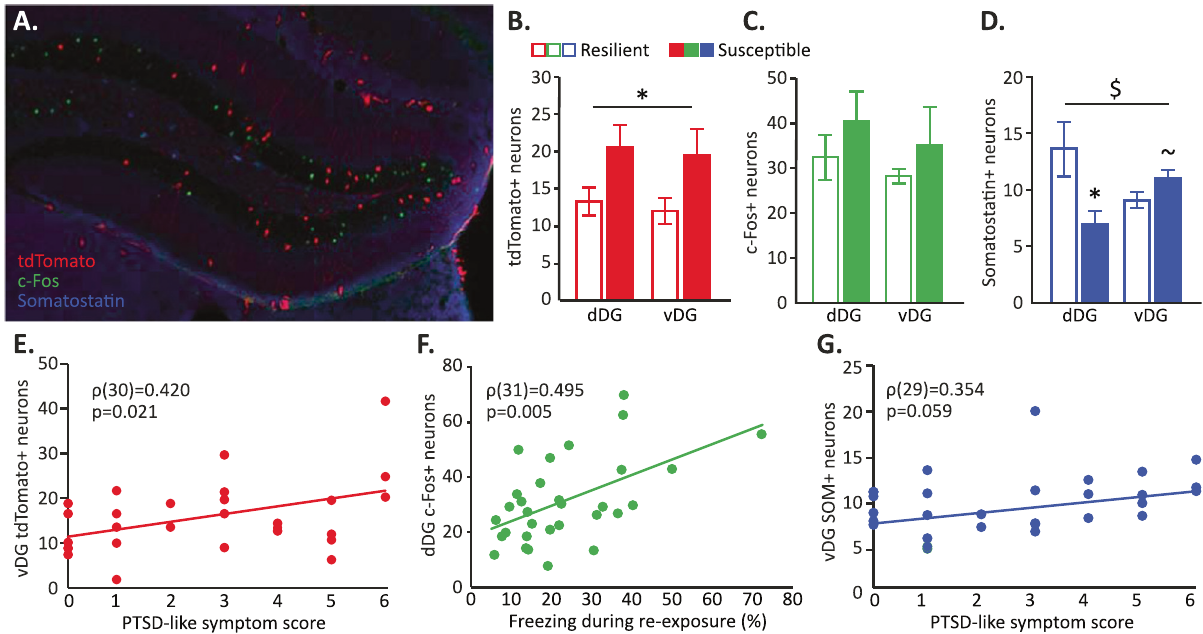
Fig. 4 DG somatostatin expression and neuronal activity related to trauma encoding and recall in susceptible and resilient mice. In cohort 4, dentate gyrus (DG) activity during trauma memory encoding (marked by tdTomato expression), remote trauma memory recall (marked by c-Fos expression), as well as somatostatin (SOM) interneuron levels were assessed by immunohistochemistry ( A ). Susceptible animals displayed an increased population of DG neurons active during trauma encoding ( B ), but no differences during its remote retrieval ( C ). The number of somatostatin neurons identi fi ed in the dorsal (dDG) and ventral (vDG) differed between groups as well ( D ). Correlational analyses involving also mice with an intermediate PTSD phenotype revealed associations between speci fi cally the ventral DG and PTSD symptom score ( E , G ), whereas the dorsal DG seemed to relate to trauma memory strength ( F ). Quality checks for the FosTRAP method are presented in Figures S9 to S11. * p < 0.05, ~ p = 0.087, effect of PTSD phenotype; $ p < 0.05, hippocampal axis × PTSD-like phenotype